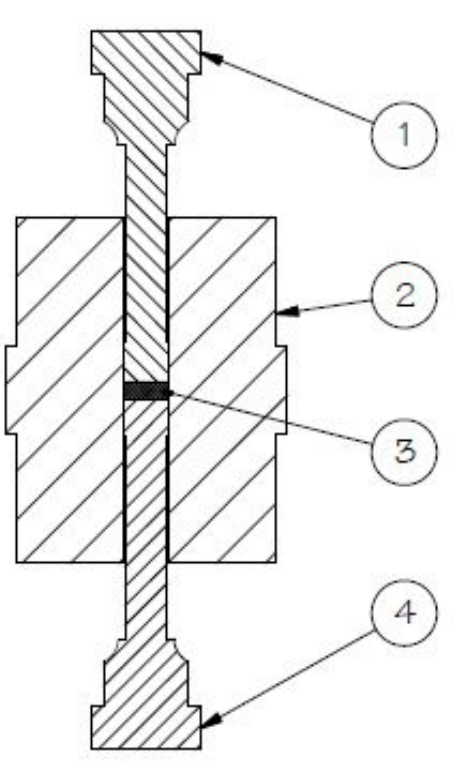
Figure 1. Pressing matrix: (1) top die punch; (2) die; (3) cathode button; and (4) bottom die punch.